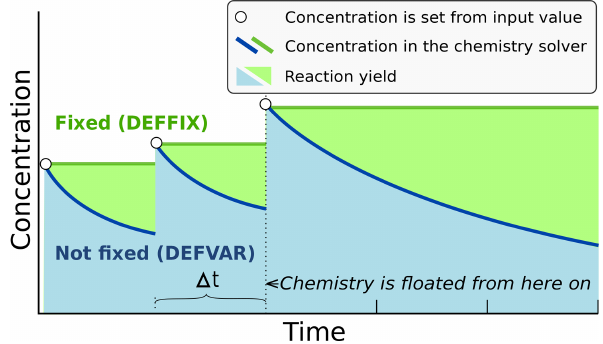
scheme, by default using KPP’s general Rosenbrock solver (Sandu et al., 1997).